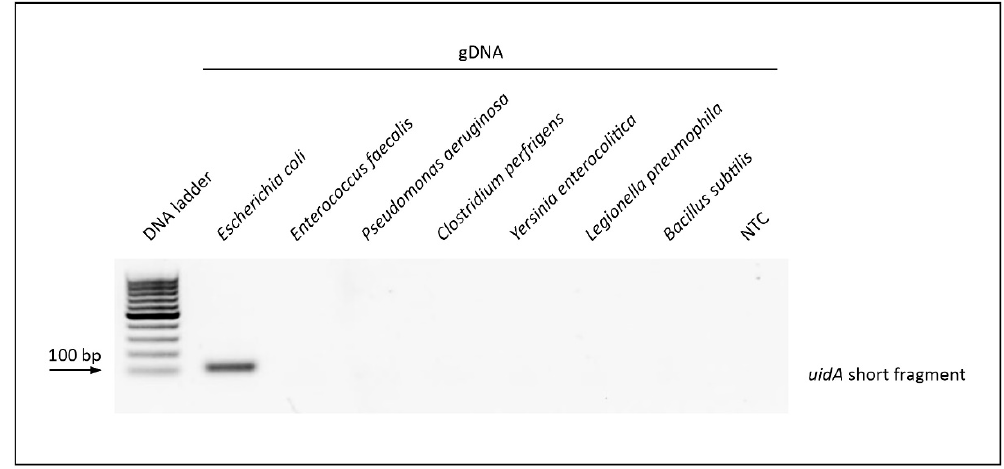
Figure 5. Primer test for amplification of the E. coli uidA gene by nested PCR displayed on an analytical agarose gel. The results of the second round are shown for E. coli , E. faecalis , P. aeruginosa , C. perfrigens , Y. enterocolitica , L. pneumophila, and B. subtilis .